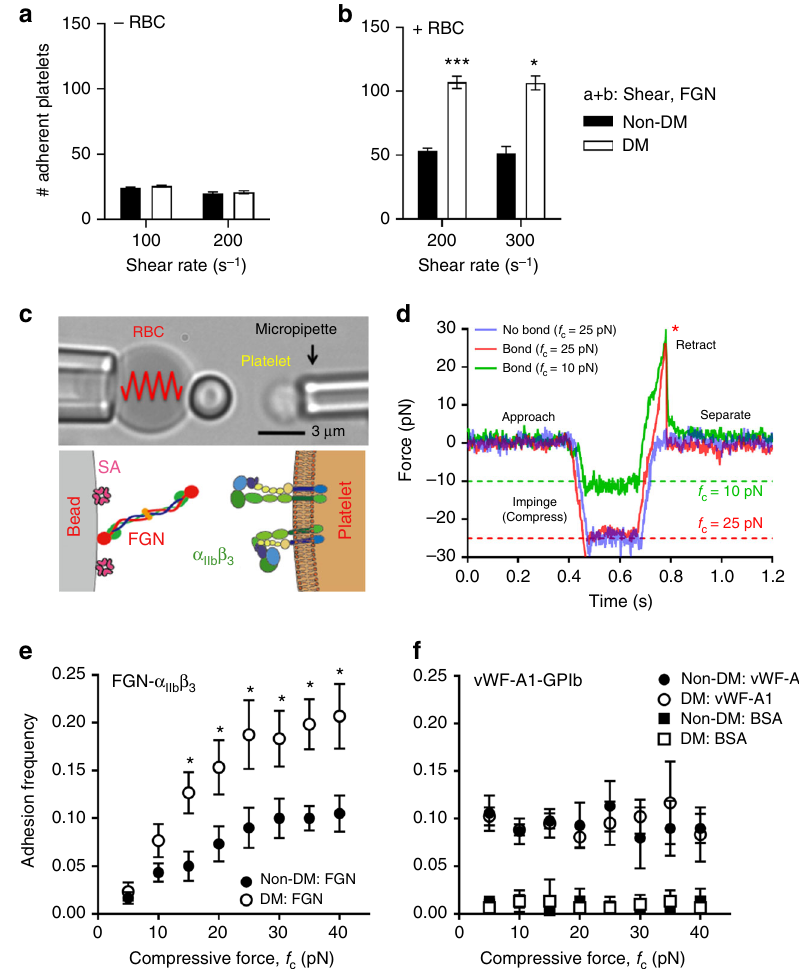
Fig. 4 Compressive force dependent enhancement in integrin α IIb β 3 – fi brinogen interaction in diabetic platelets. a , b Isolated platelets from non-DM and DM mice were perfused over FGN matrices at the indicated shear rates, in the absence ( a , − RBC) or presence ( b , + RBC) of RBC reconstitution. The number of adherent platelets was determined following 3 min of perfusion time. c Schematic illustration of the biomembrane force probe (BFP) setup. (Top) The micropipette-aspirated platelet is driven forward to touch and then retracted back from the adhesive ligand- (i.e., FGN or vWF) coated bead, which is attached to a RBC aspirated by another micropipette. (Bottom): each ‘ touch-retract ’ cycle allows platelet surface integrin α IIb β 3 to associate and then dissociate with FGN on the bead. d Illustration of bond detection using BFP. The platelet is driven to touch the probe bead under a compressive force ( f c ) of 10 (green) or 25 pN (red), held in contact for 0.2 s, and then retracted. In a ‘ bond ’ event (green and red), a loading force increases until the bond rupture (red asterisk), whereas a ‘ no-bond ’ event shows zeroforce (blue). e , f Non-DM (closed circles) and DM (open circles) mouse platelets were subjected to 50 BFP cycles under the indicated compressive forces ( f c = 5 – 40 pN) using beads coated with FGN ( e ), vWF-A1 or BSA ( f ), and the number of ‘ bond ’ events over the total number of events was analysed and expressed as adhesion frequency. All results are expressed as mean ± s.e.m. of n = 3 mice. For each experiment, adhesion frequencies were measured and averaged from ≥ 4 platelet – bead pairs. Results were assessed using an unpaired, two-tailed Student ’ s t -test, where * p < 0.5; ** p <